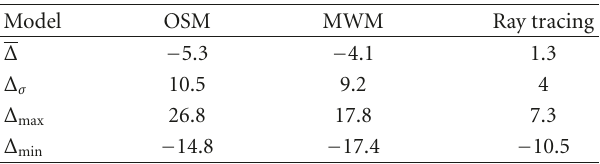
Table 4: Path loss prediction error statistics of COST 231 models and calibrated ray